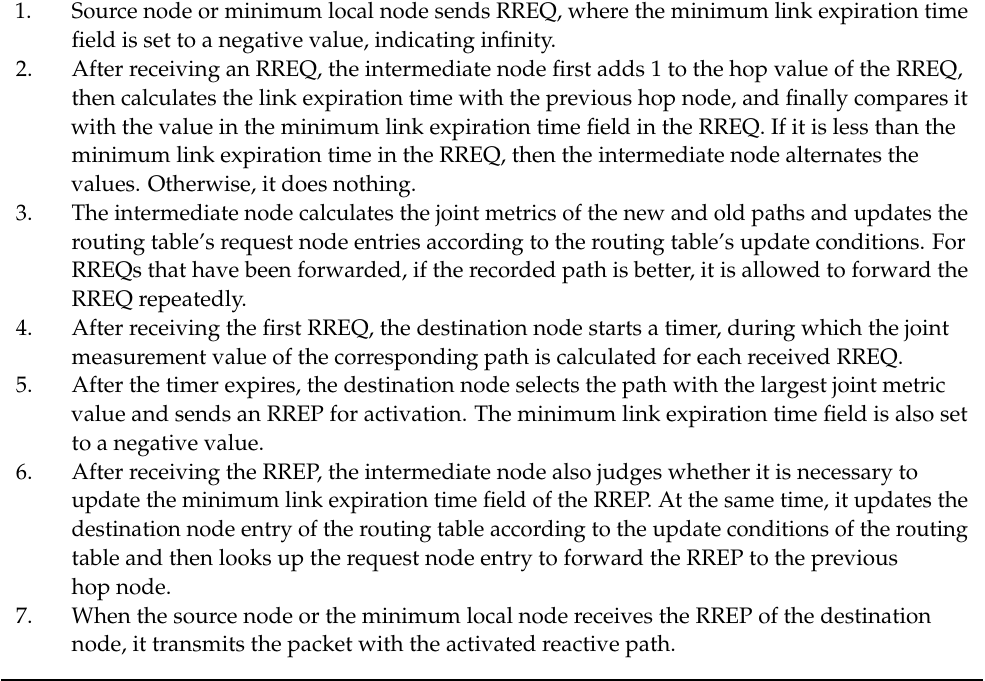
Algorithm 1: The path construction process of the reactive mechanism of the RGF